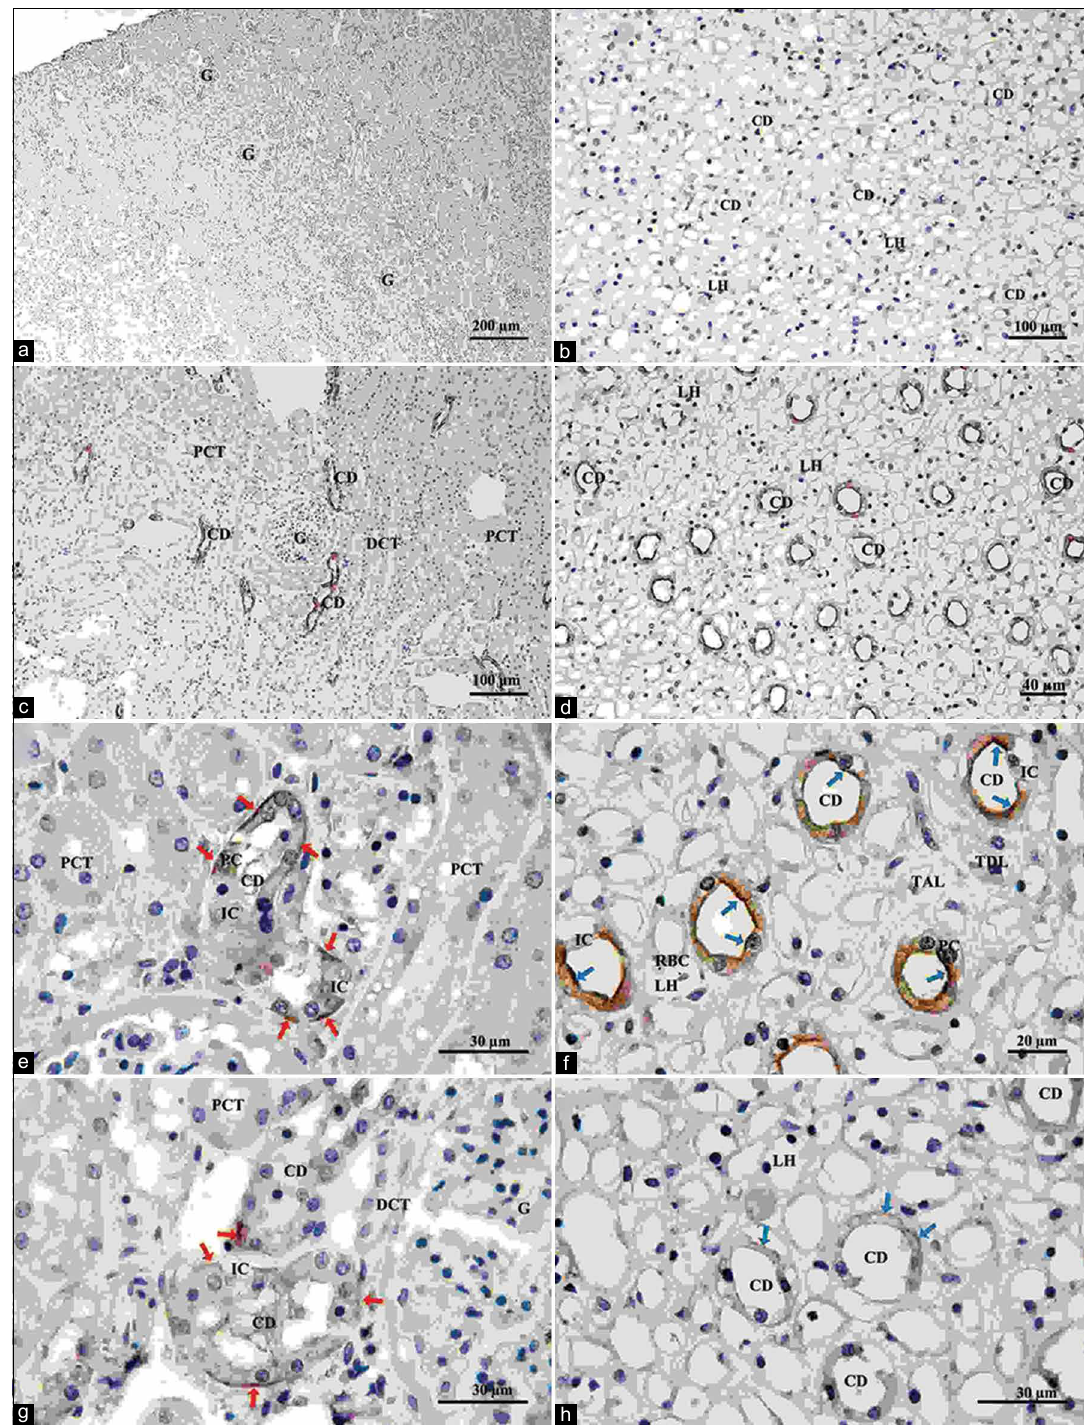
Figure-1: Low and high magnification of histological and immunohistochemical localization of aquaporin (AQP) 2 and arginine vasopressin receptor (AVPR) 2 in the cortex and medulla. Negative control in the cortex (a) and medulla (b). Immunolocalization immunoperoxidase labeling of AQP2 in the cortex (c and e, red arrow) and medulla (d and f, blue arrow). Immunolocalization immunoperoxidase labeling of AVPR2 in the cortex (g, red arrow) and medulla (h, blue arrow). The proteins’ localization and expression were shown in brown. AQP2 was found in the basolateral and apical membranes of the principal cells, whereas AVPR2 was found in the basolateral membrane of the principal cells in the renal cortex and the renal medulla. CD=Collecting duct, DCT=Distal convoluted tubule, G=Glomerulus, IC=Intercalated cell, LH=Thin segment Henle’s loop, PC=Principal cell, PCT=Proximal convoluted tubule, RBC=Red blood cell, TAL=Thick ascending Henle’s loop, TDL=Thick descending Henle’s